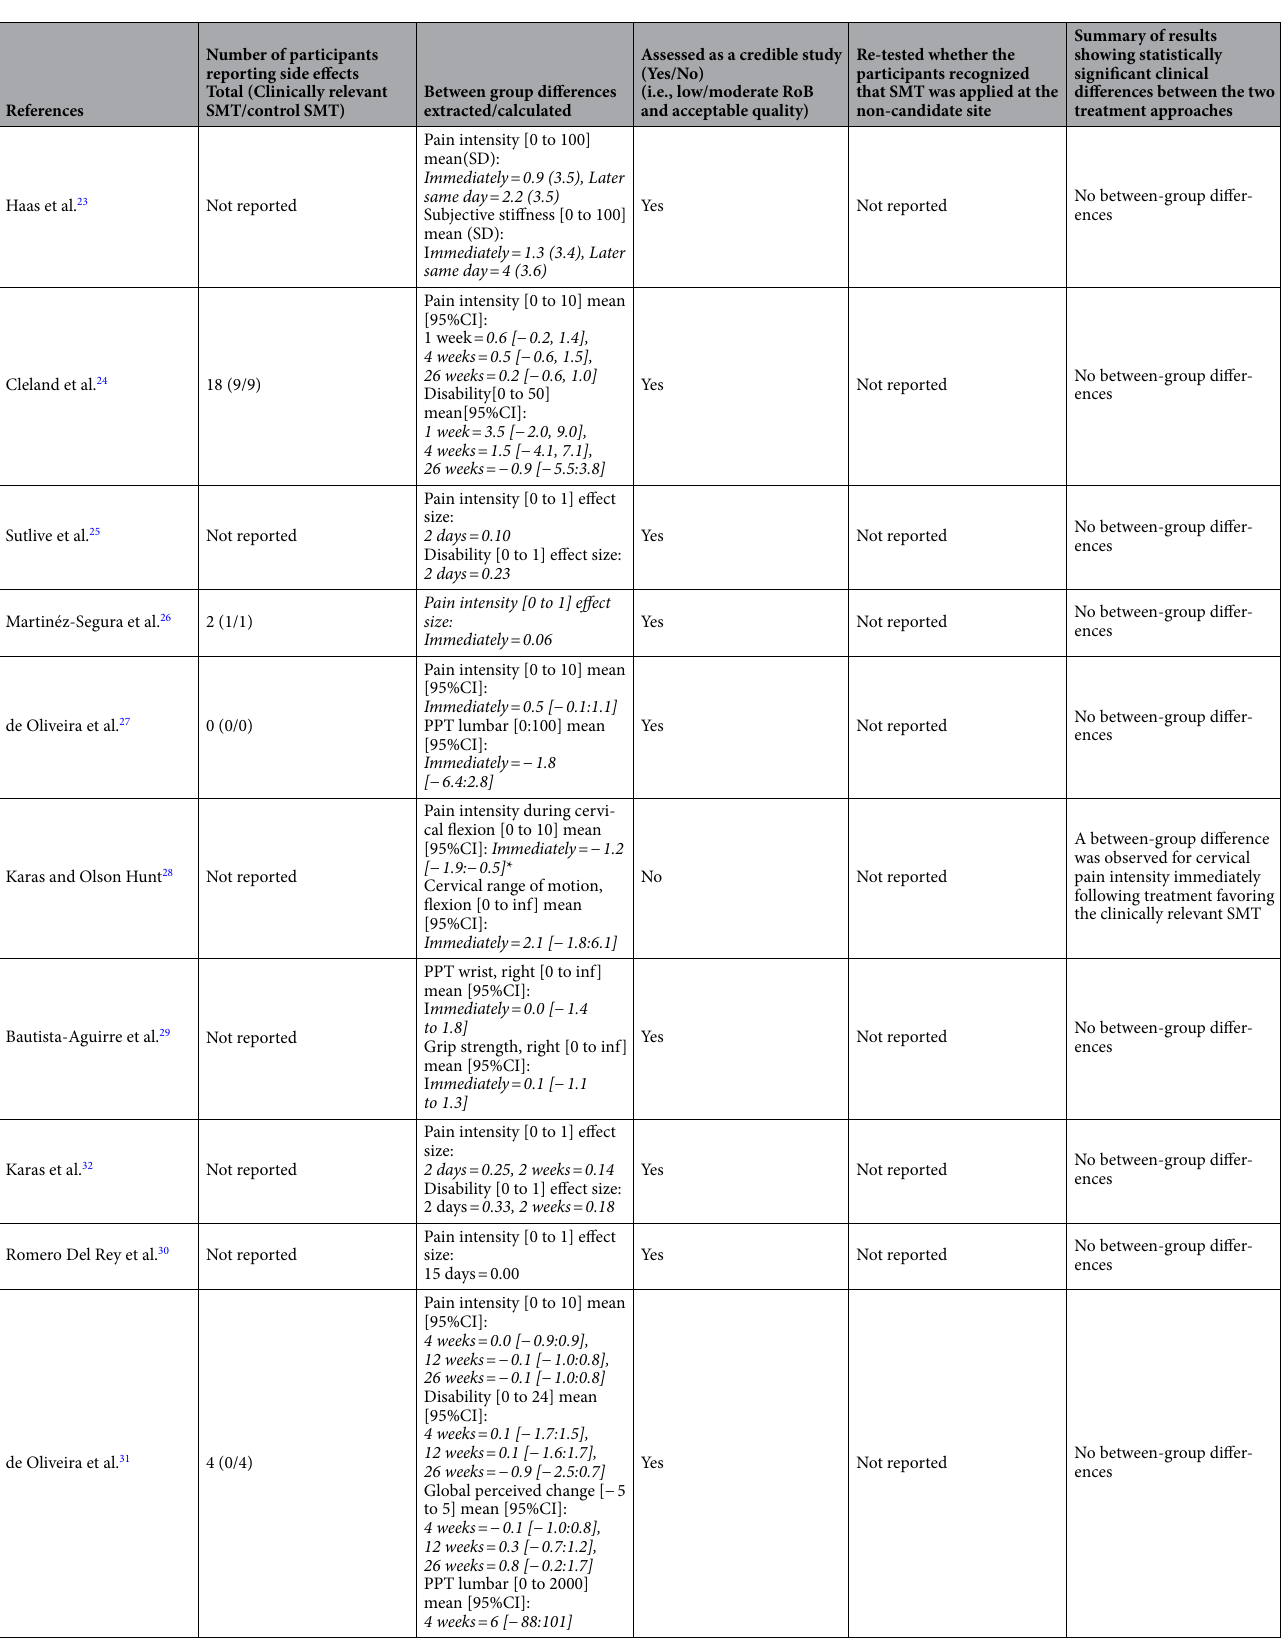
Table 3. Results from 10 studies included in a systematic review comparing the outcome of applying spinal manipulative therapy at a candidate site versus a non-candidate site. PPT, pressure pain detection threshold; 95%CI, 95% confidence intervals. *reported as a statistically significant between-group